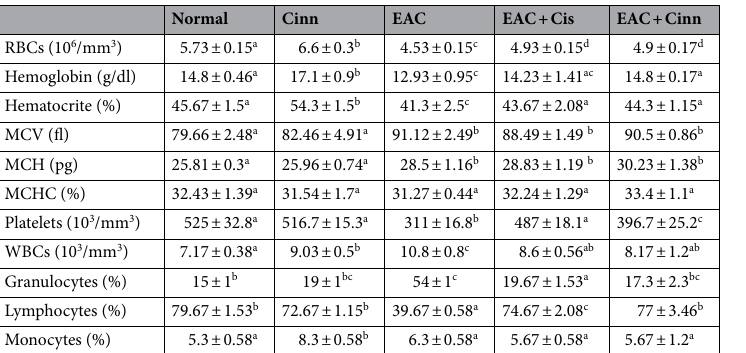
Figure 13. The effect of cinnamon essential oil (Cinn, 50 mg/kg b.wt/day, orally) on the percentage of splenic CD3 - CD8 + CD56 + cells after 12 days of treatments. ( A ) Representative flow cytometric dot plot analysis (BD Accuri C6 software, version 1.0.23.1, San Jose, CA, USA, www. Accur iCyto meters. com). ( B ) Statistical data were represented as (Mean ± SD), n = 3. Significant differences ( P < 0.05) between groups were shown by different letters. EAC, Ehrlich ascites carcinoma; Cis, Cisplatin (2 mg/kg b.wt, i.p). Normal